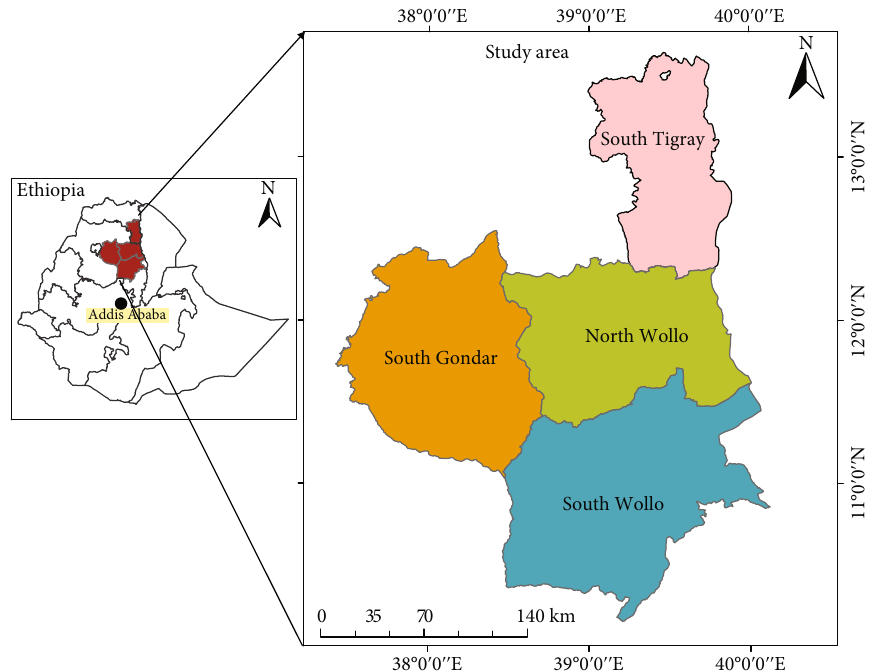
Figure 1: Map showing the study areas on parasitic weeds a ff ecting food legumes in North